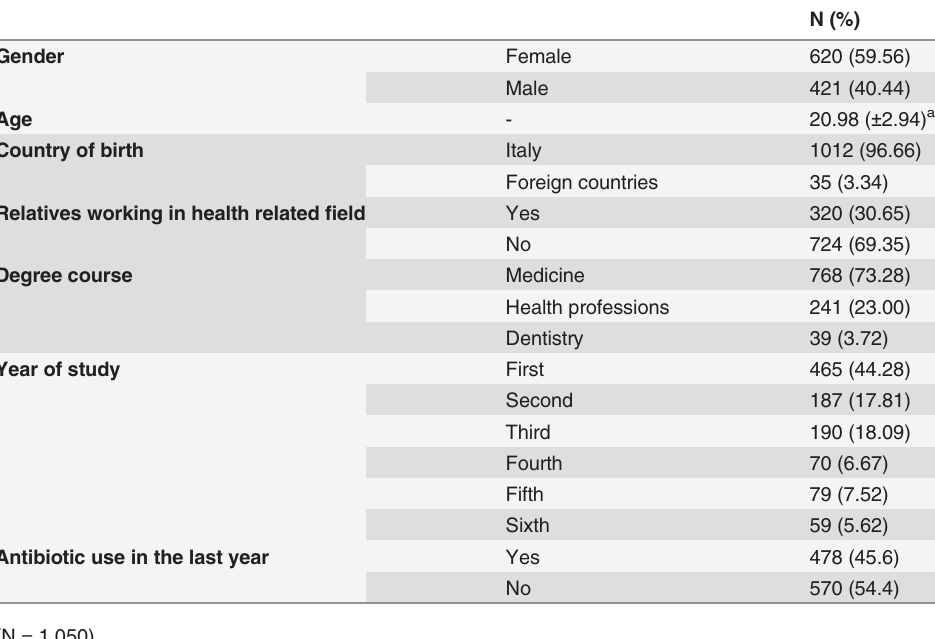
Table 1. Description of the